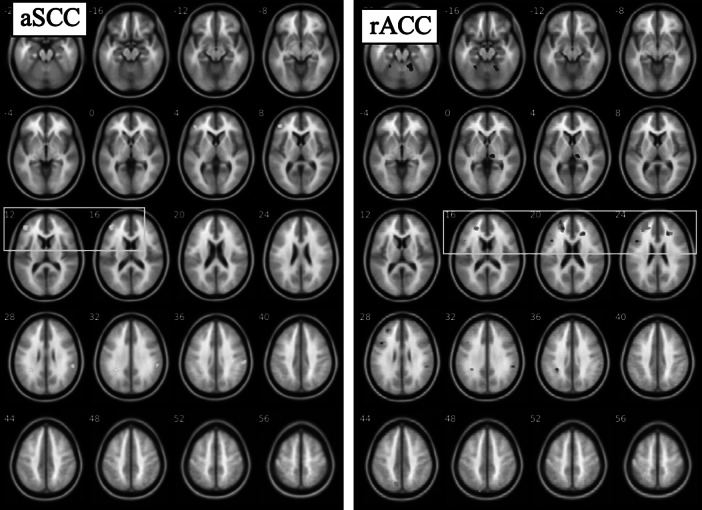
Anterior subcallosal cingulate (aSCC) and rostral anterior cingulate (rACC) resting-state functional connectivity associated with depression symptom severity (Beck Depression Inventory [BDI]) in major depressive disorder group at baseline (N = 30). For aSCC, regions negatively correlated with BDI include lateral prefrontal cortex (box), supramarginal gyrus, and parietal lobe; for rACC, regions positively correlated with BDI include fusiform and thalamus (top two rows), while regions negatively correlated with BDI include inferior frontal gyrus, dorsolateral prefrontal cortex (box), parietal cortex, and precuneus. Maps thresholded at p < 0.001, k > 40 for display purposes.